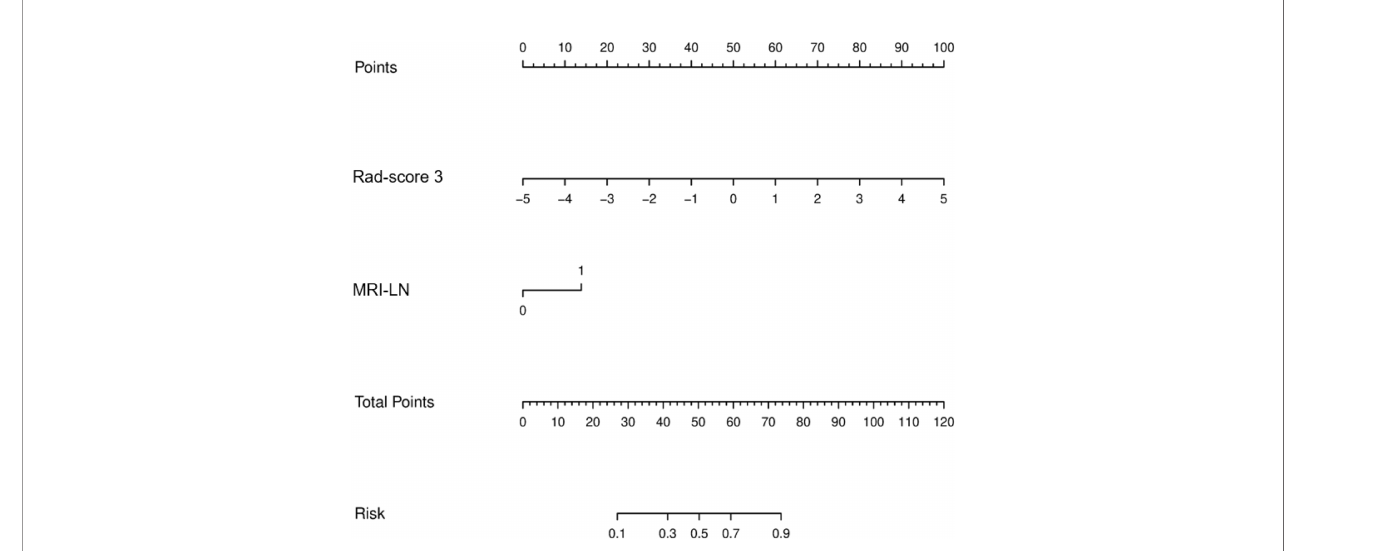
FIGURE 4 | Radiomics nomogram incorporating the MRI-reported LN status and rad-score 3. MRI-LN, MRI-reported LN status.